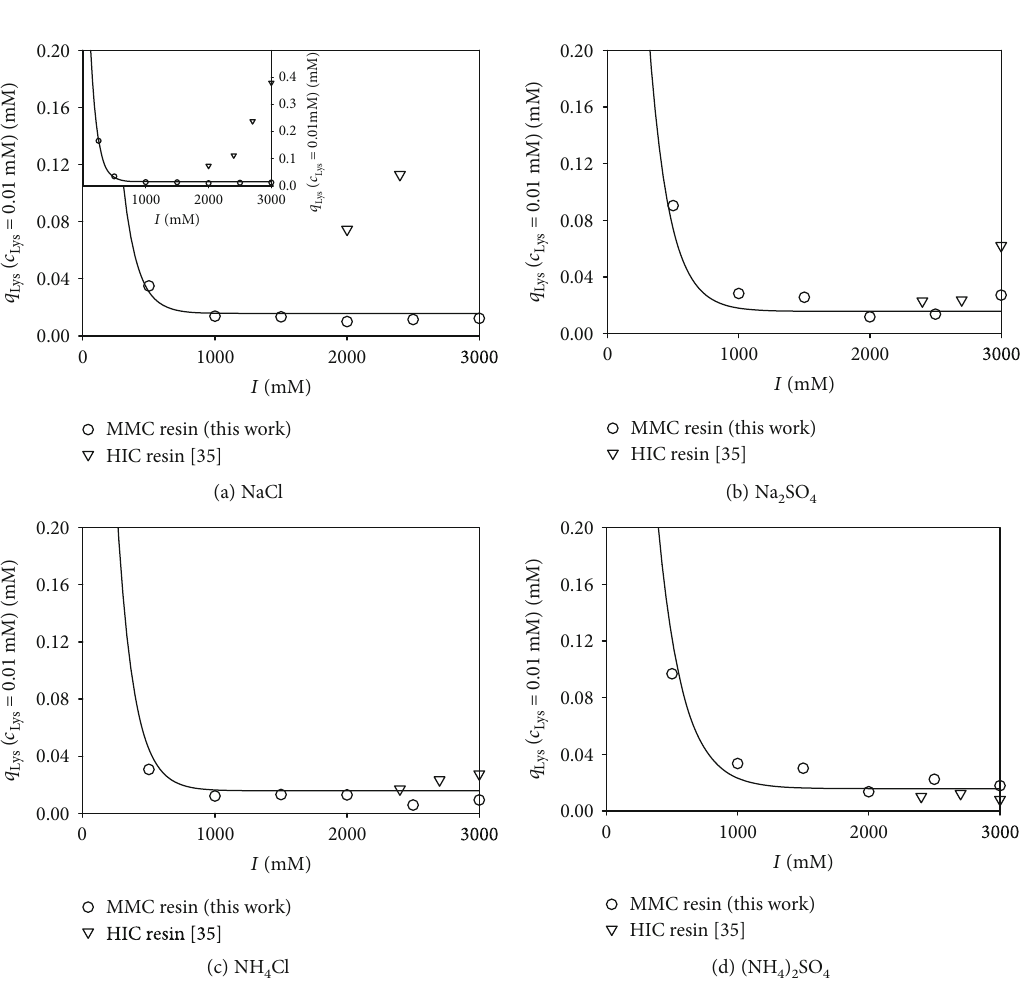
Table S.2 in the Supplementary Materials.